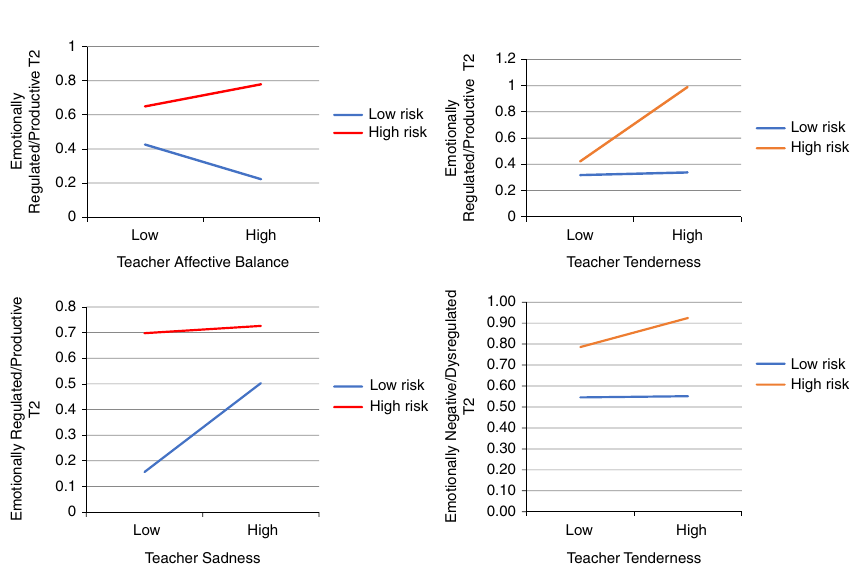
Table I. HLM analyses examining the contribution of teacher emotions, socioeconomic risk and their interactions to children ’ s observed emotional competence